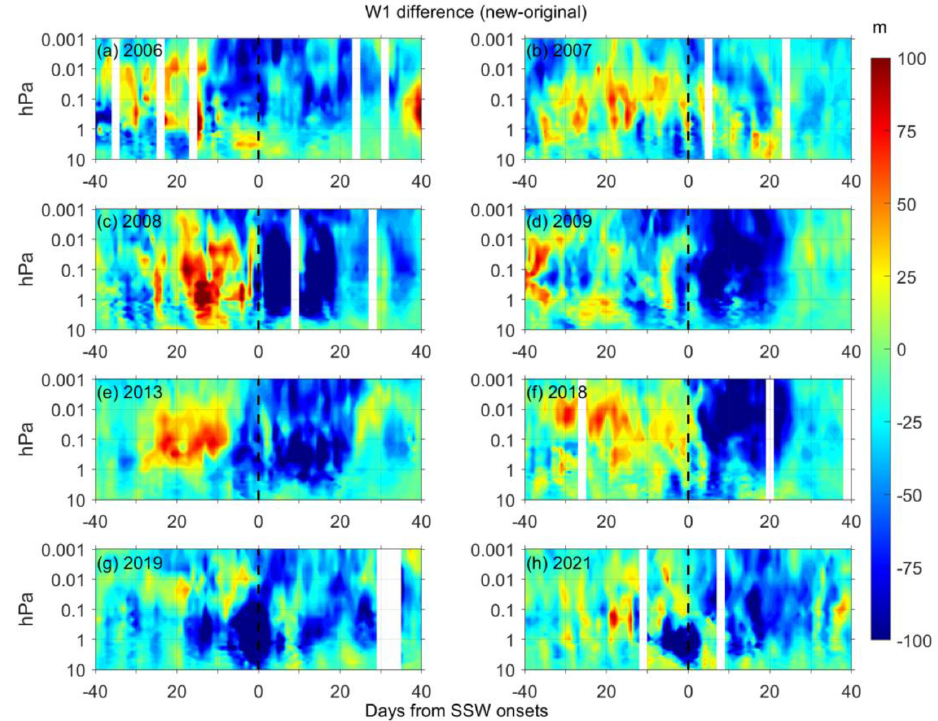
Figure 6. The differences in the fitted W1 Q5DO amplitudes between the new and original methods during eight major SSWs from 2006 to 2021 (a–h) . Contour steps are 5m.